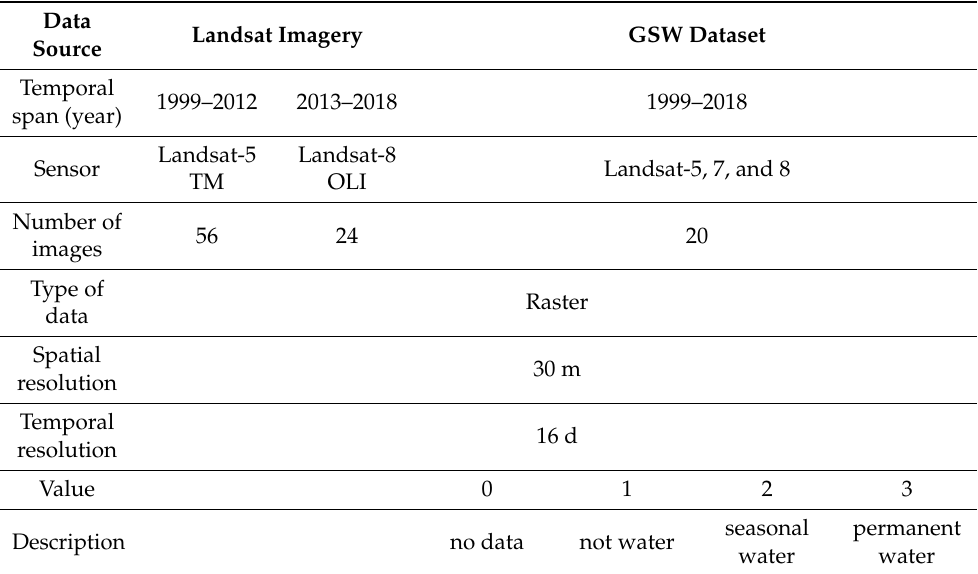
Table 1. Detailed information on Landsat imagery and Global Surface Water (GSW) dataset used in this